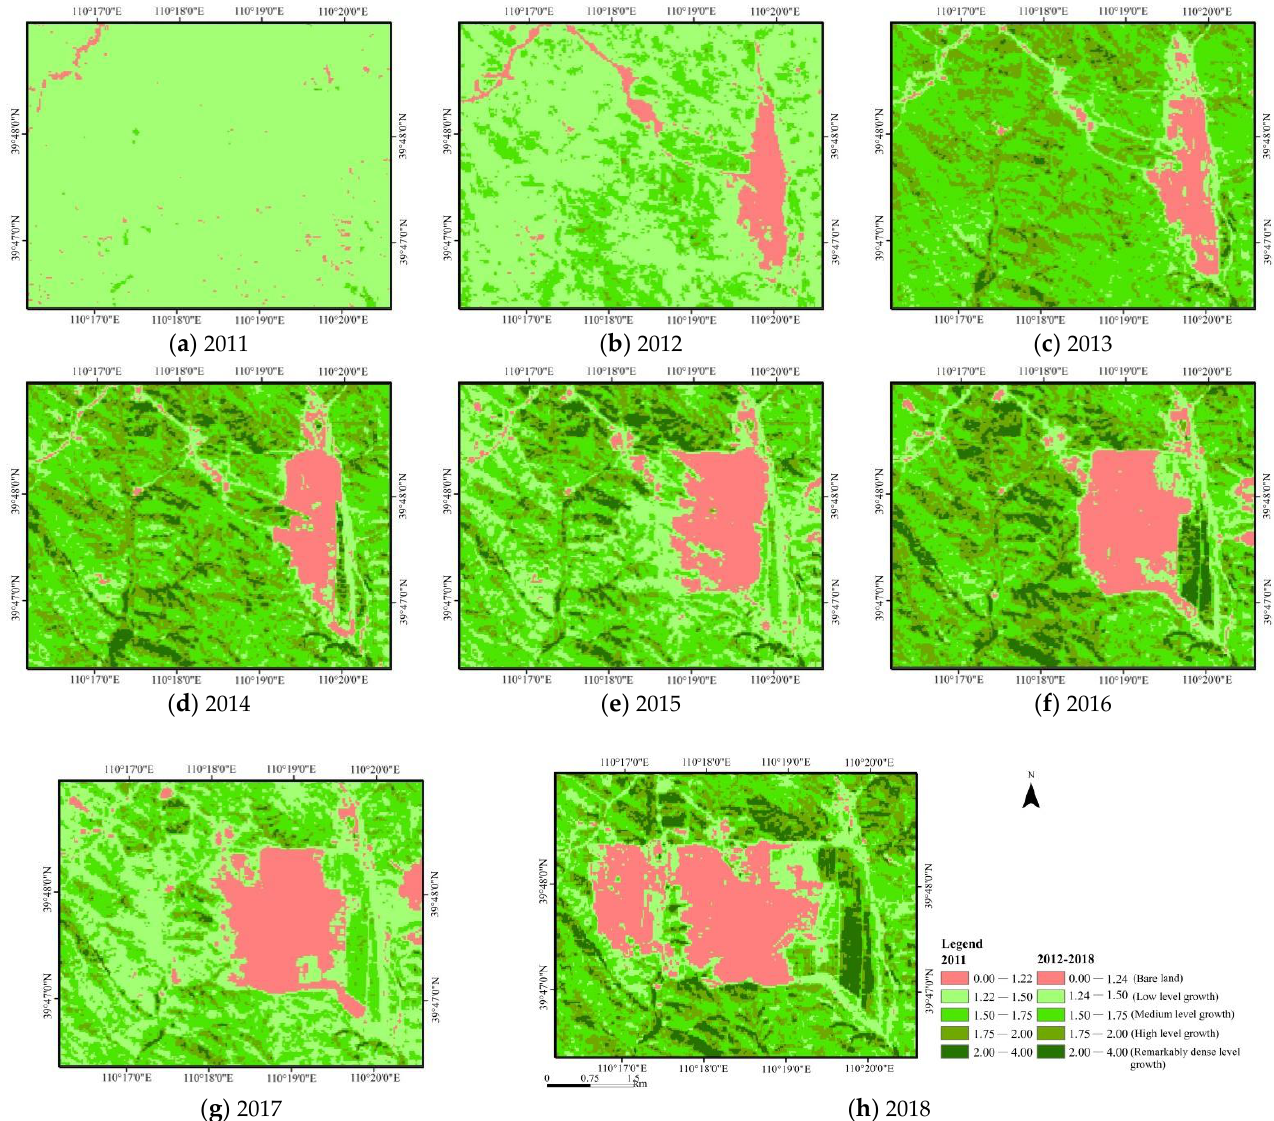
Figure 5. Spatial distribution of the GRNDVI levels from 2011 to 2018 in the study region.